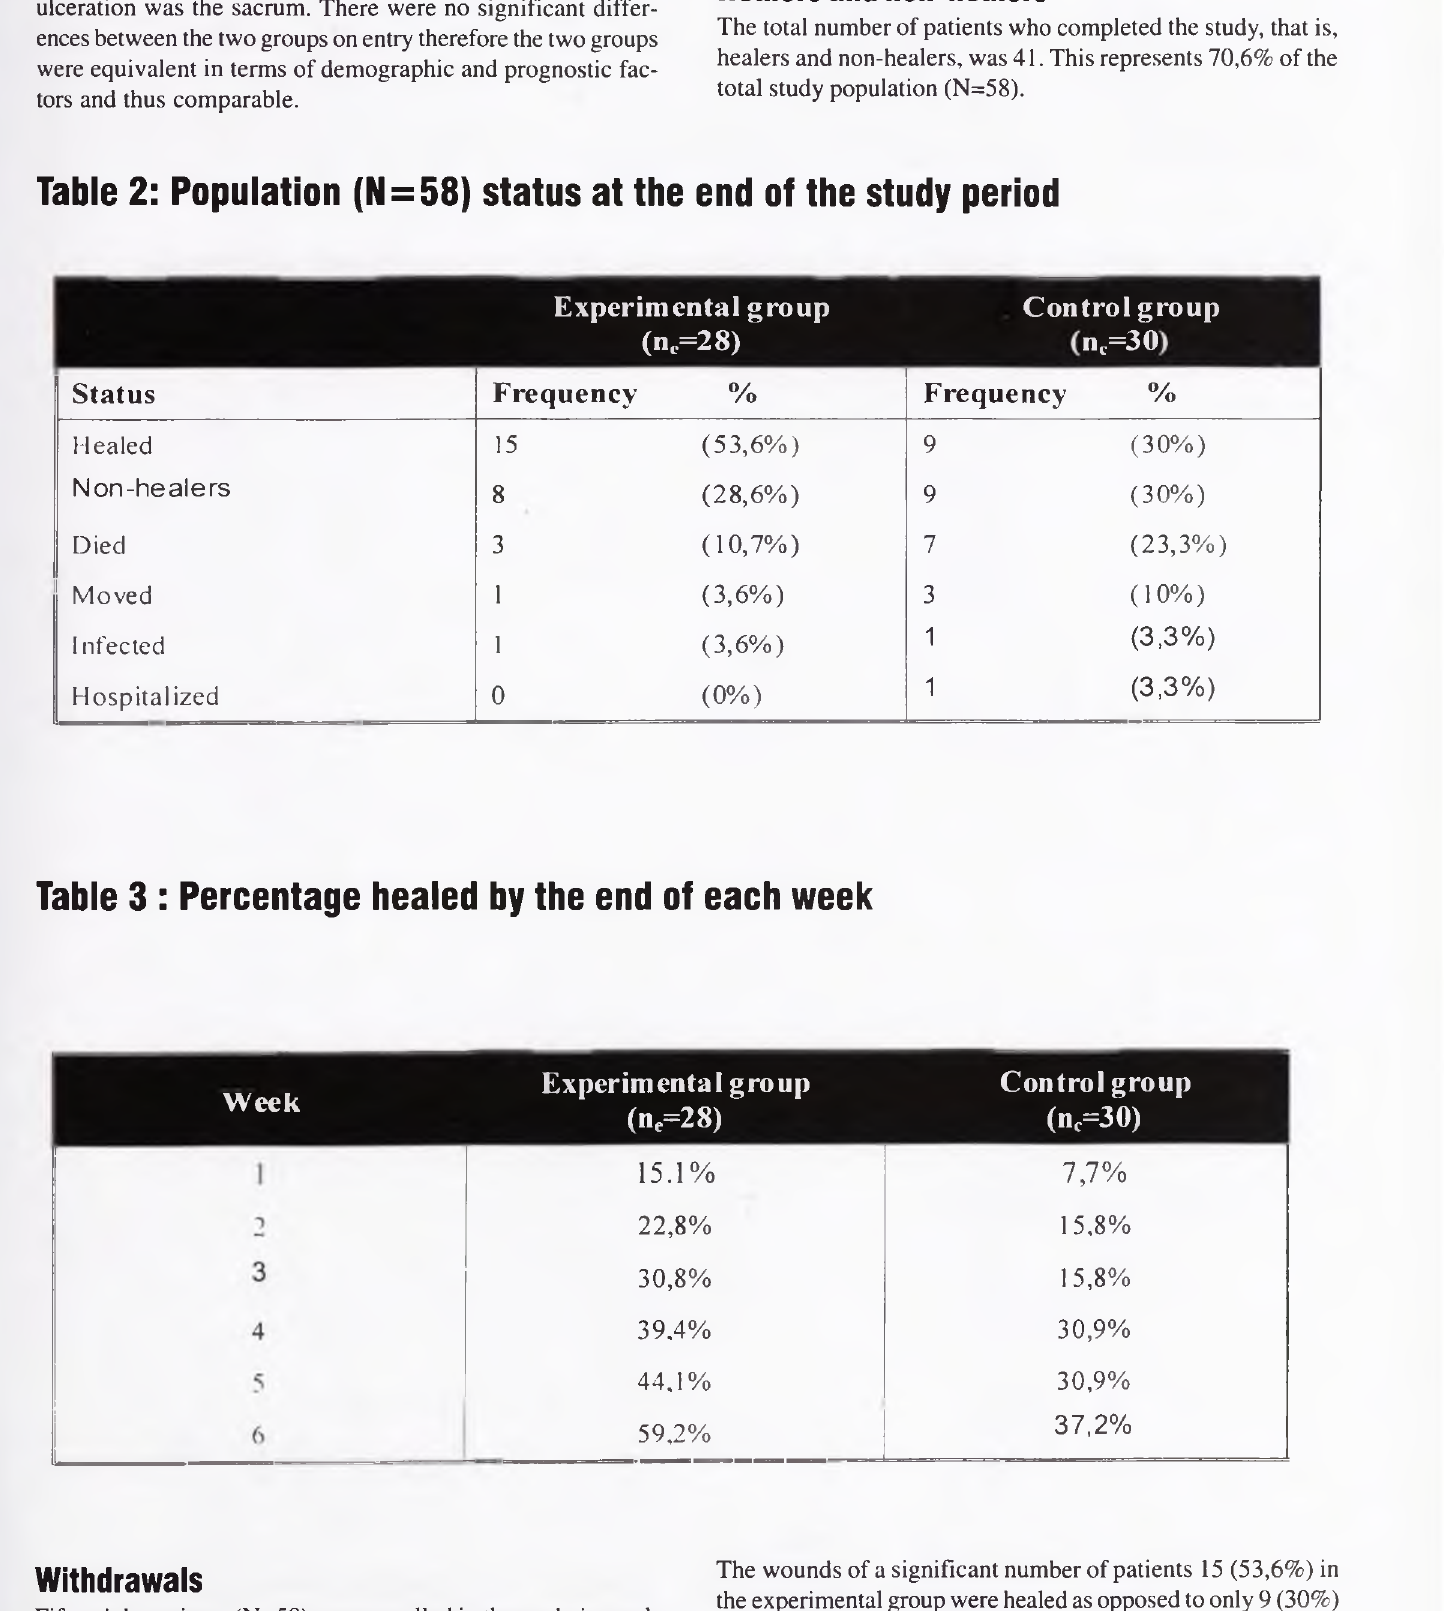
Table 2: Population (N = 5 8 ) status at the end of the study period